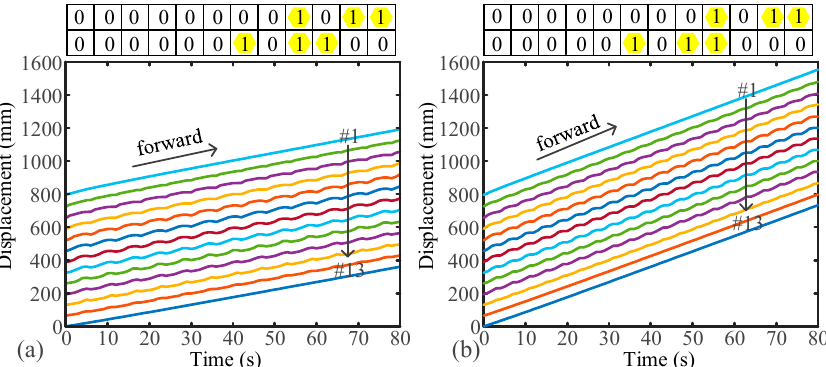
Figure 13. Locomotion simulations of a 12-segment earthworm-like robot based on B-DM with MG-II. The line located in the number is the locomotion tracks of body segments. Three actuated segments in the B-DM of four body segments (“1011”). ( a ) The transmission segments consist of two segments. ( b ) The transmission segments consist of three segments.